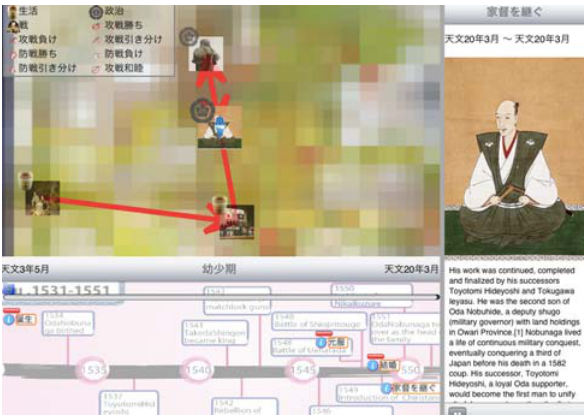
Figure 4. A detailed timeline can be presented after visiting the timeline in Figure 3. A picture and the description of Nobunaga Oda in this figure are used from